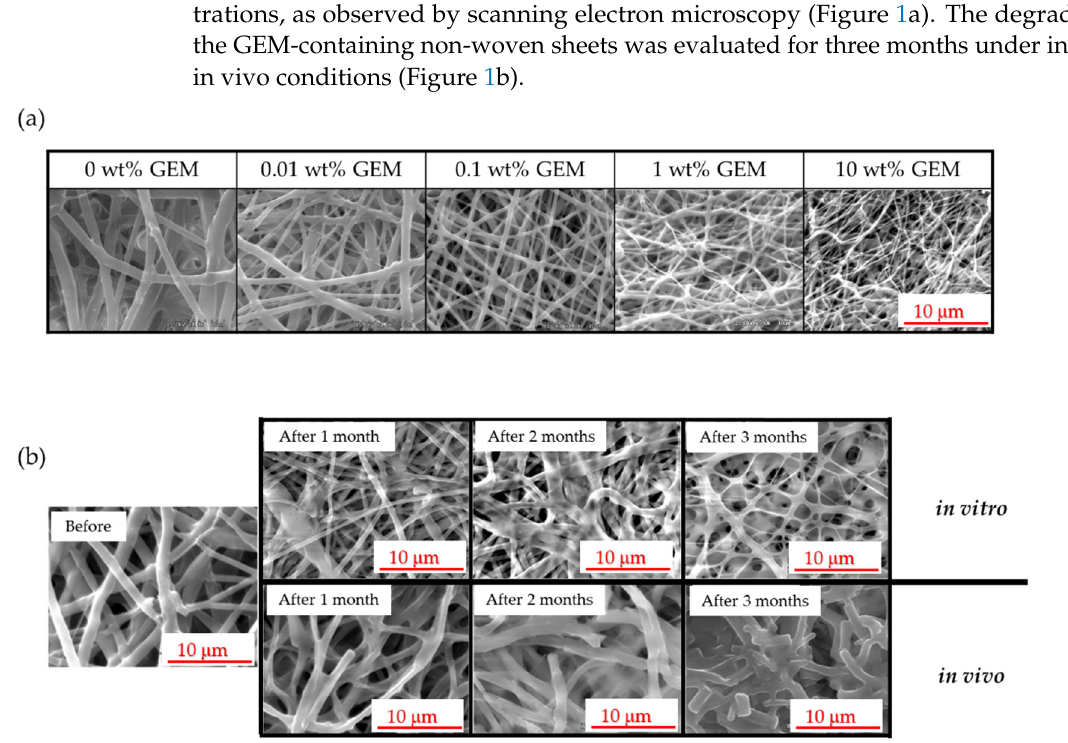
Figure 1. Scanning electron micrographs of GEM-containing non-woven sheets. ( a ) Scanning electron microscopy images of GEM-free and GEM-containing non-woven sheets at concentrations ranging from 0.01% to 10% content. Scale bar: 10 μ m. ( b ) Scanning electron microscopy images of denatured GEM-free non-woven sheets after 1, 2, and 3 months of in vitro or in vivo evaluation. Scale bar: 10 μ m.